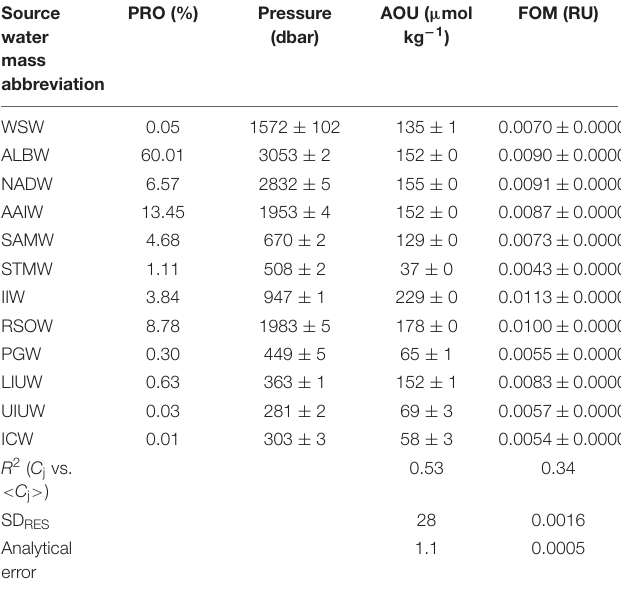
TABLE 2 | Archetypal values of the pressure, AOU, and FOM with the proportion of source water mass.